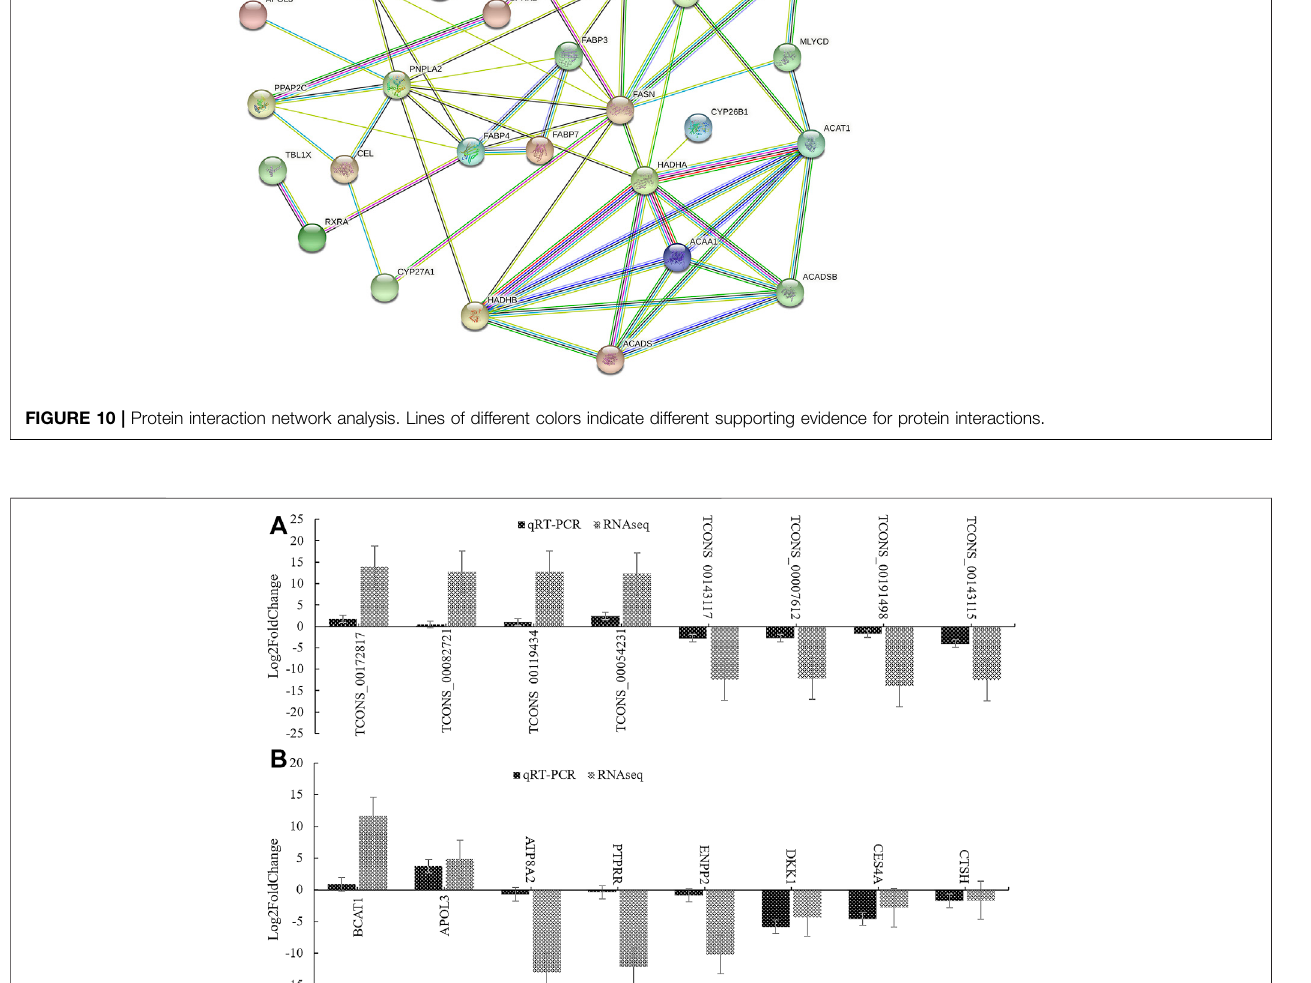
Frontiers in Genetics | www.frontiersin.org February 2022 | Volume 13 | Article 772115